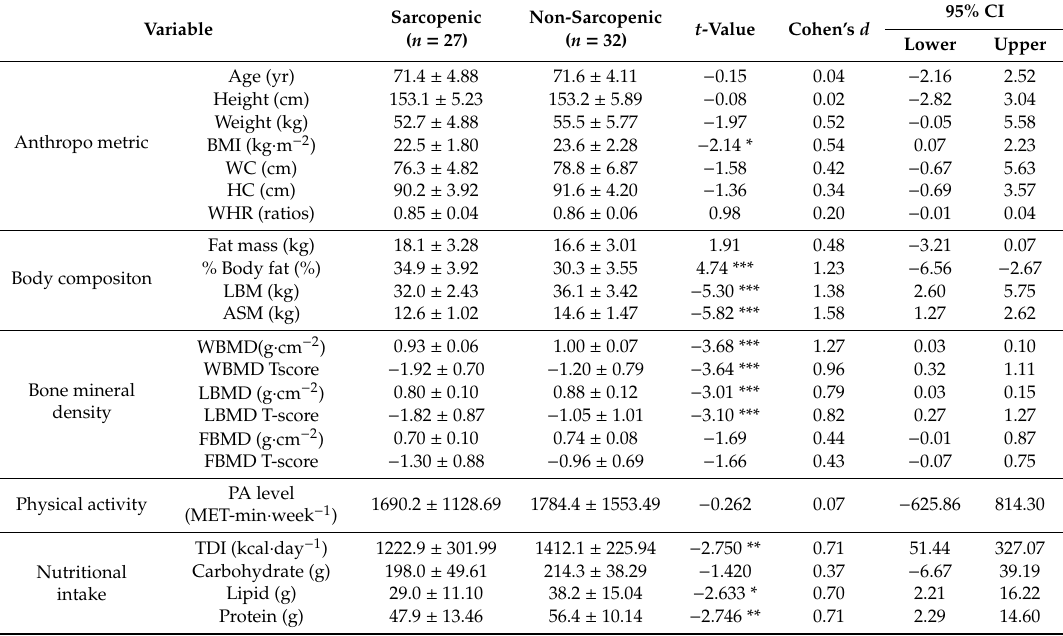
Table 1. Comparison of anthropometric, body composition, bone mineral density, physical activity, and nutritional intake between sarcopenic and non-sarcopenic